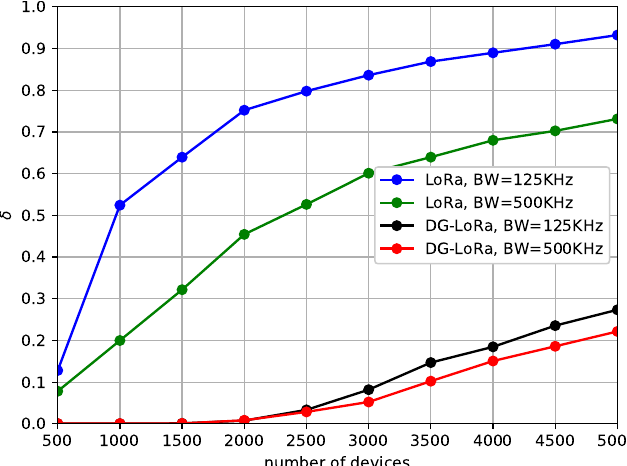
Figure 10. The number of retransmissions according to the channel